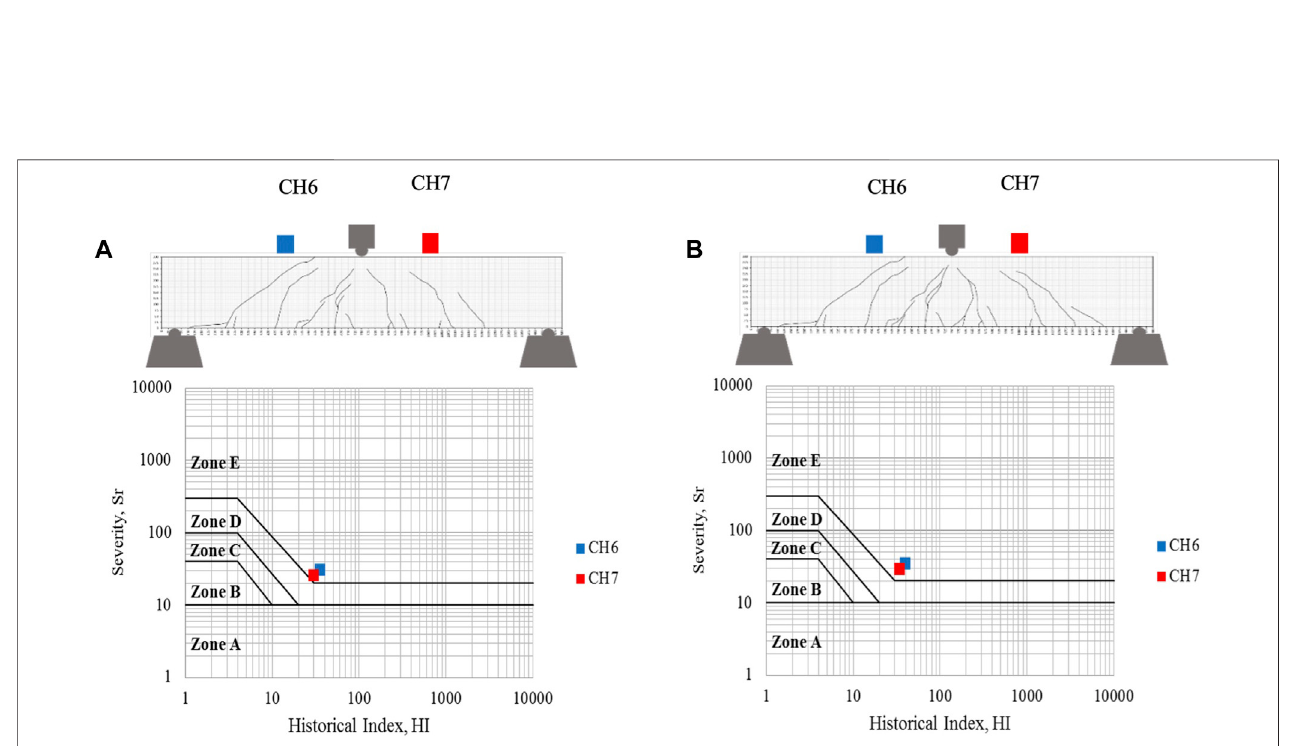
FIGURE 10 | The crack zones obtained from CH6 and CH7 for beam S1C (A) CM3 and (B) CM4.